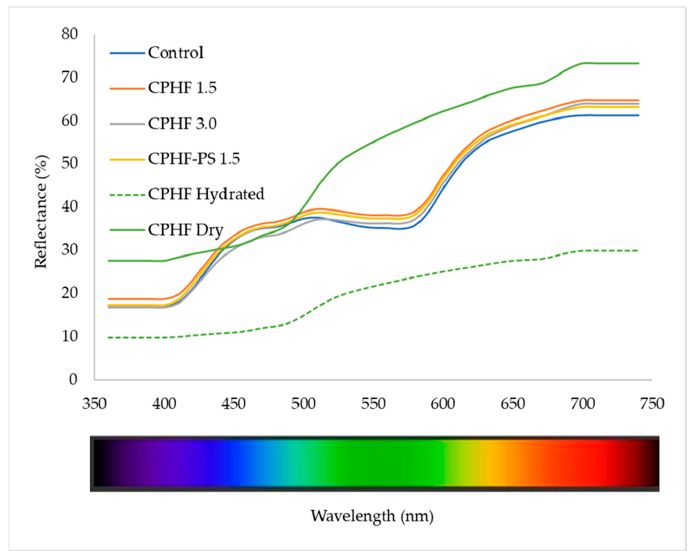
Figure 1. Reflectance spectra (360–740 nm) of cacao pod husk flour (CPHF) (dry and hydrated) and the frankfurters with the addition of CPHF. CPHF Dp < 200 μ m. 3.5.2. Reflectance Ratios R630/R580, R650/R570, and R560/R500